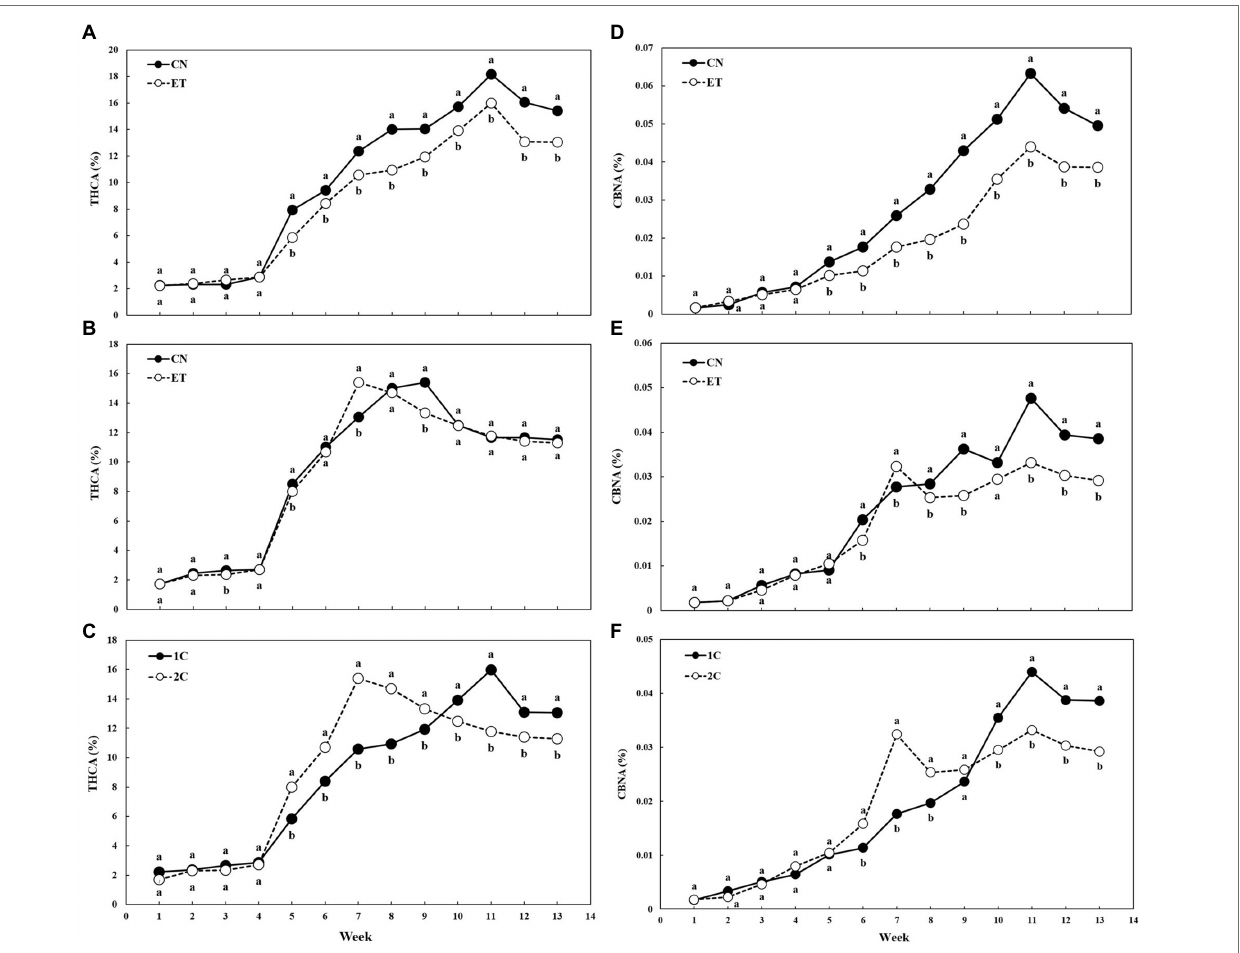
FIGURE 7 | Concentrations of tetrahydrocannabinolic acid (THCA) and cannabinolic acid (CBNA) in the flowers of medical cannabis plants as affected by amino acid (AA) supplementation and nutrient cycle. THCA concentration in control (CN) and enhanced treatment (ET) plants with AAs nutritional supplements in recirculation (1C) growing cycle (A) , in drain-to-waste (2C) growing cycle (B) , ETs in 1C and 2C (C) . CBNA concentration of control (CN) and enhanced treatment (ET) with AAs nutritional supplements in recirculation (1C) growing cycle (D) , in drain-to-waste (2C) growing cycle (E) , ETs in 1C and 2C (F) . The whole inflorescence of the plant was analyzed. Data are means ± SE ( n = 3). Different bold small letters represent significant differences in cannabinoid concentration between the variants in a particular week according to Tukey’s HSD test at α =